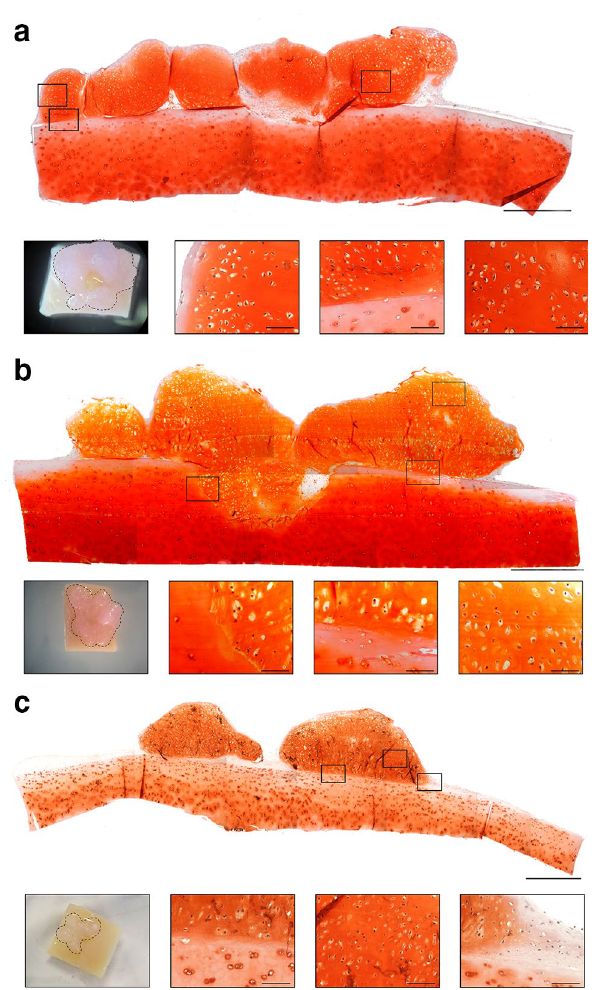
Figure 3. Scale up of hESC-derived cartilage tissue constructs using co-culture on native human articular cartilage. Photographs showing 3 independent, 16-week co-cultures of hESC-derived cartilage tissue measuring ~ 6 × 6 × 1 mm (demarcated with a dashed line) on pieces of full-thickness human articular cartilage ( a , b , c ). Histological sections stained with Safranin O showing hESC-derived cartilage tissue cultured on human articular cartilage displaying sGAG-rich matrix and hyaline morphology with chondrocytes in clearly defined lacunae. Scale bars represent 1 mm (low magnification) and 100 µm (high